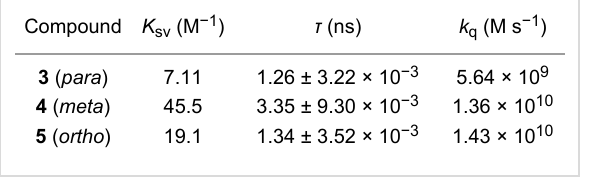
Table 1: Stern–Volmer quenching constants (Et 3 N as a quencher) and singlet lifetimes for the isomeric acetylenes 3–5.